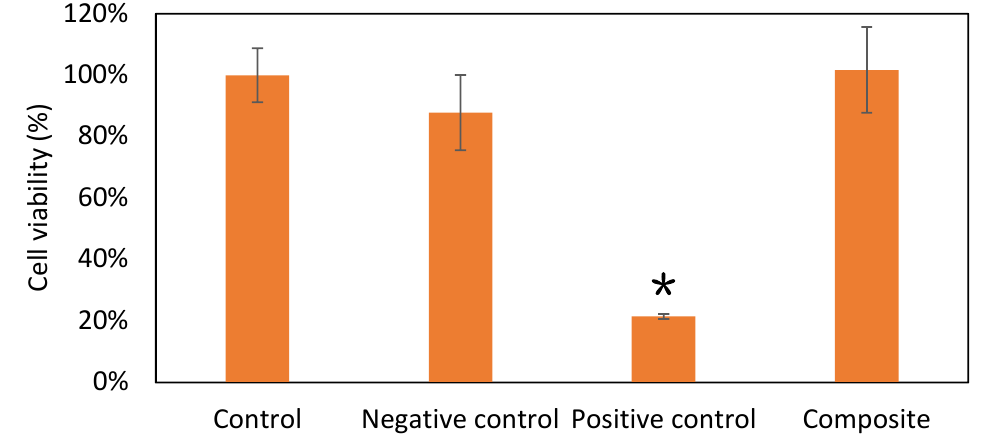
Figure 6. Viability of cells ( n = 6). Data are expressed as means ± standard deviation (SD). Full cell viability (100%) was defined by the control group. Compared with the other three groups, the Gel/HA–HAP composite showed no cell toxicity. * p < 0.001.